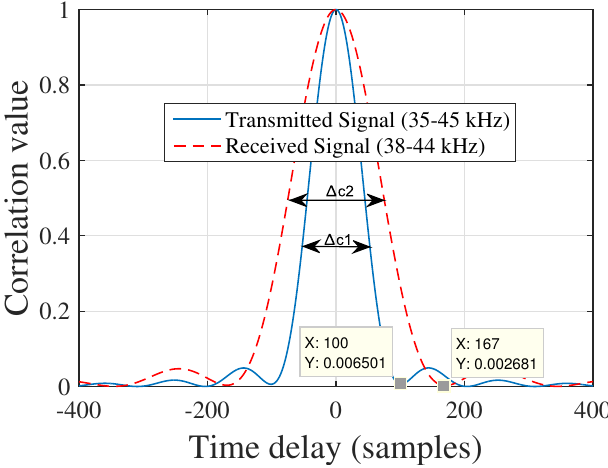
Figure 9. Auto-correlation width of the transmitted and received signal where the correlation width ( ∆ c 1) 100 and ( ∆ c 2) 167 refers 10 kHz and 6 kHz respectively according to the formula ∆ c (cid:39) ± 1